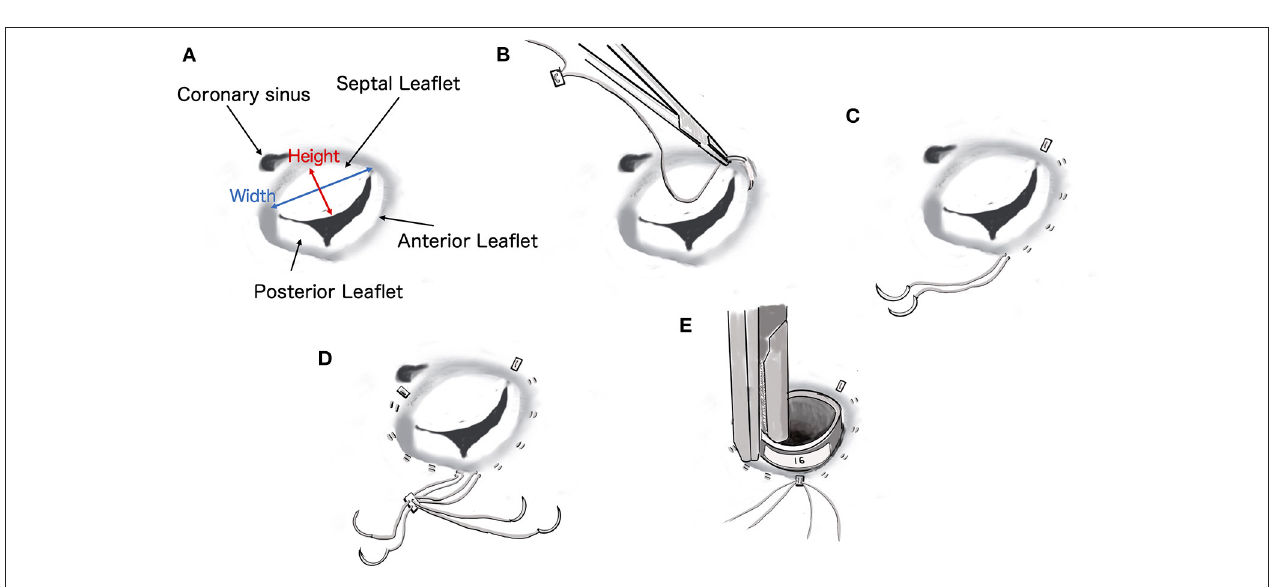
FIGURE 2 | Diagrammatic representation of the procedure for De Vega tricuspid annuloplasty. The size of the cylindrical sizer was 16mm, which was set based on the height and width of the septal leaflet (17 and 14mm, respectively).